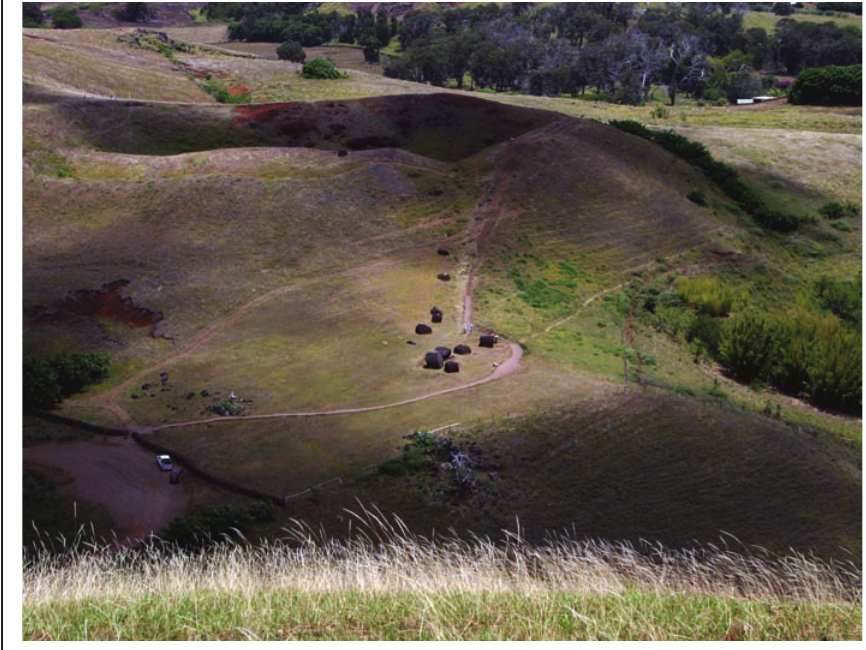
Figure 5 The red scoria quarry of Puna Pau. Note the line of “abandoned” statue hats leading away from the crater en route to ahu sites.